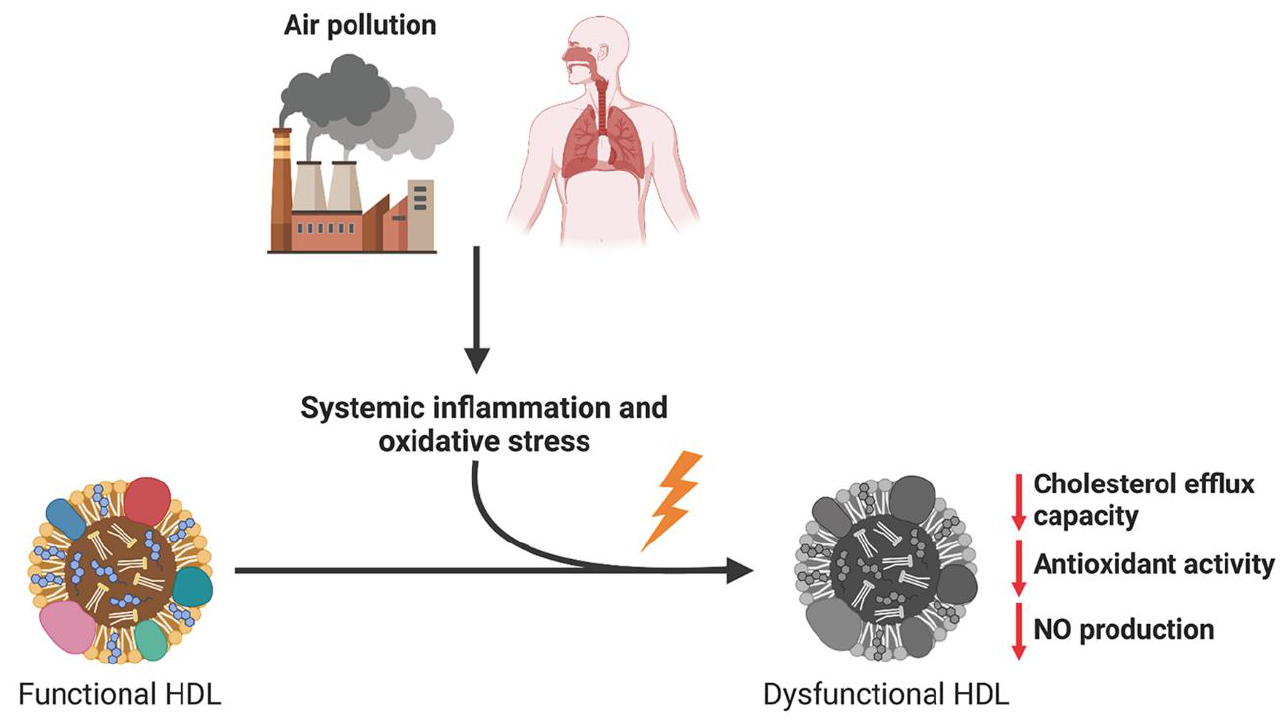
Figure 4. Effects of air pollution on HDL function.